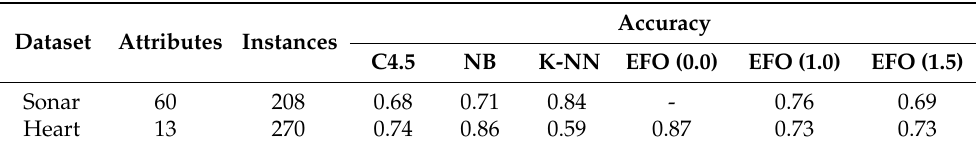
Table 4. Comparison of the here obtained performances (in terms of accuracy) with those published in ref. 28 (i.e., C4.5, NB and k-NN) for the two used UCI